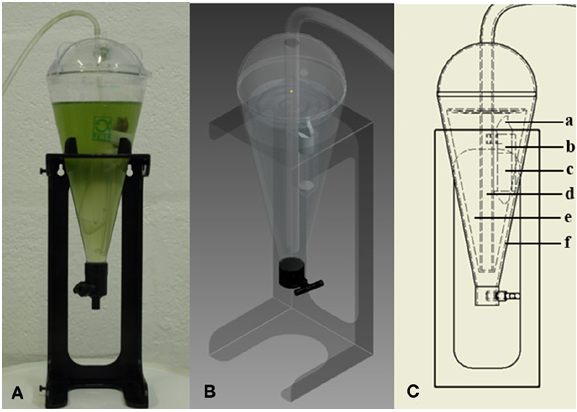
Fig. 1. – Photograph (A), simplified CAD model (B) (rotated view) and annotated diagram (C) of the standard experimental setup used, where a, is adult barnacle capitulum; b, adult barnacle stalk; c, tube with cyprids and adult stalk in seawater; d, airline; e, surrounding seawater; and f, conical flask. The setup consists of a 500-ml conical flask containing seawater, which holds internally a vertically placed 50-ml tube (whose lid has been cut off) containing an adult barnacle (held vertically by the Parafilm used to seal the tube), whose capitu- lum extends towards the outside and the stalk towards the inside of the tube. The inner tube contained both the adult barnacle stalk and cyprids, while on the outside of the tube the barnacle could extend the cirri and feed on microalgae without the risk of